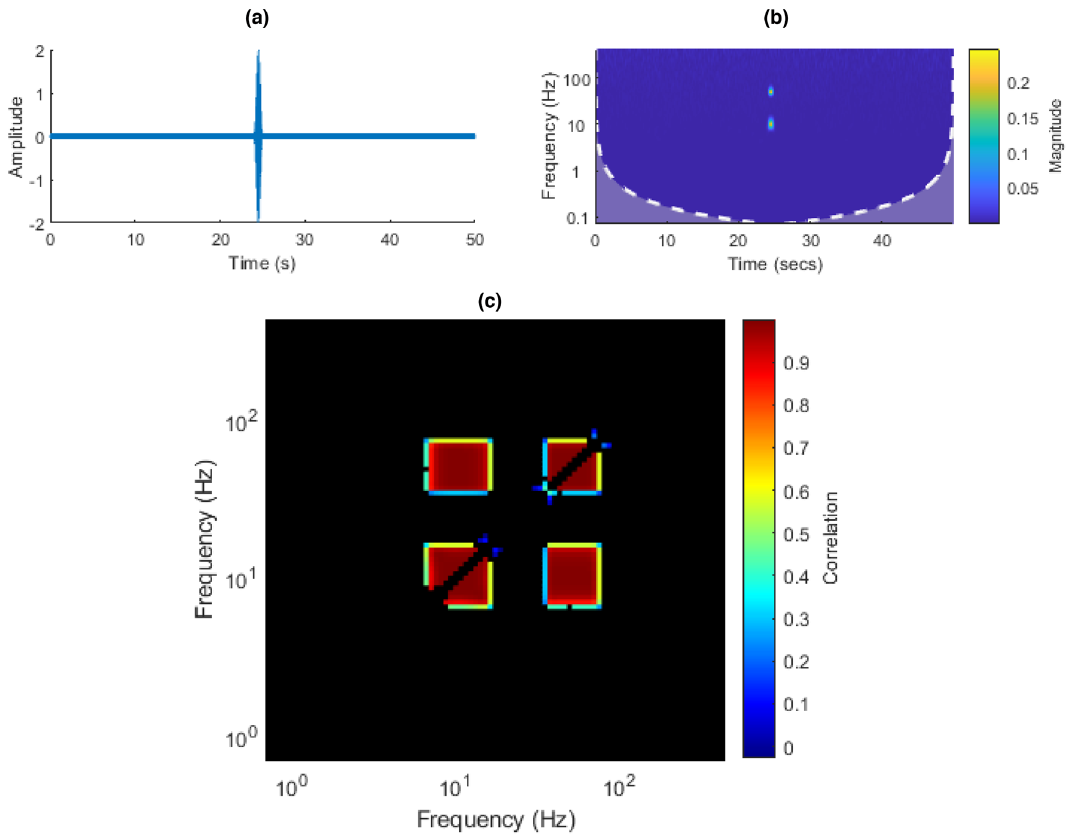
Figure 13. ( a ) Double-sinusoid time domain plot. ( b ) Double-sinusoid CWT. ( c ) Double-sinusoid ISPCM, black elements represent non-statistically significant correlations at an FDR α of